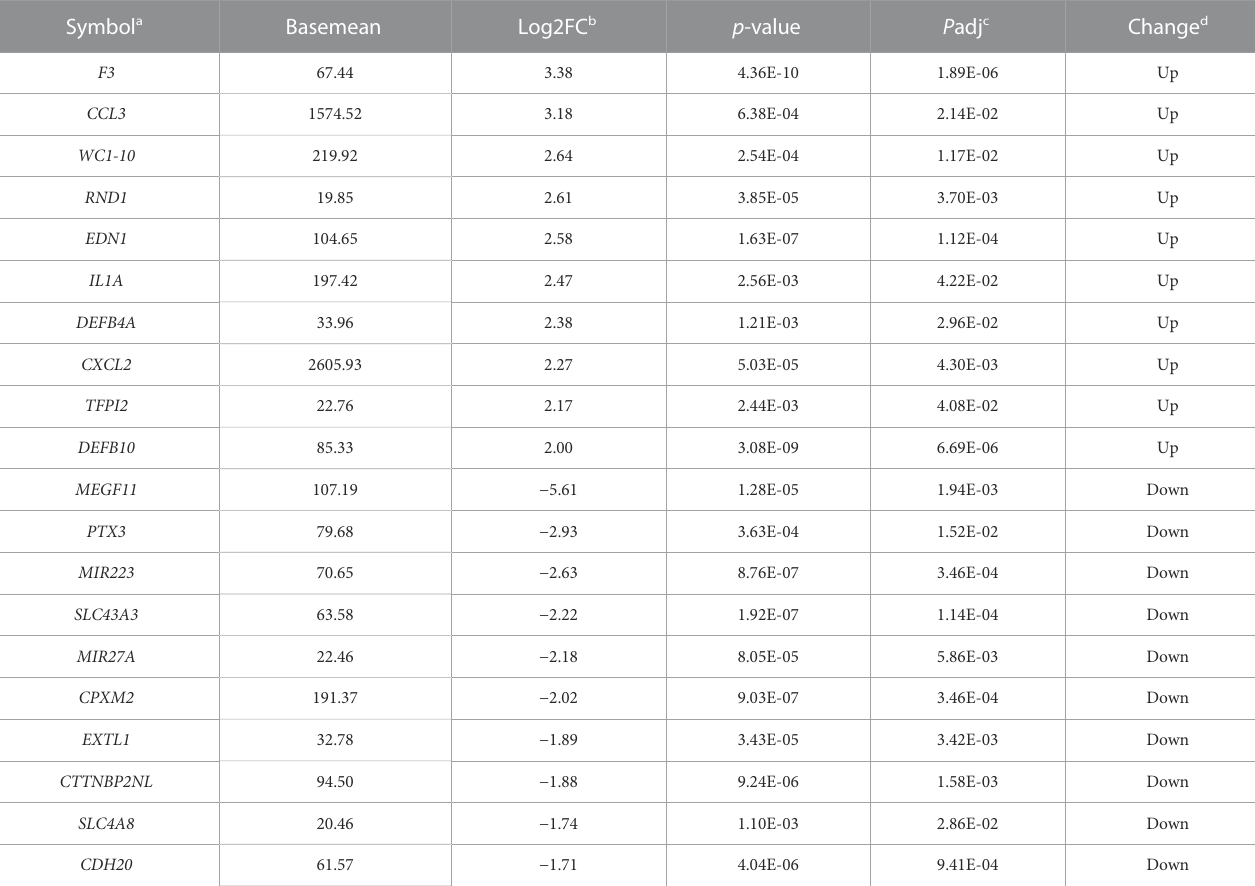
TABLE 3 The top 10 up- or down-regulated genes identi fi ed in pasteurized group. Symbol a